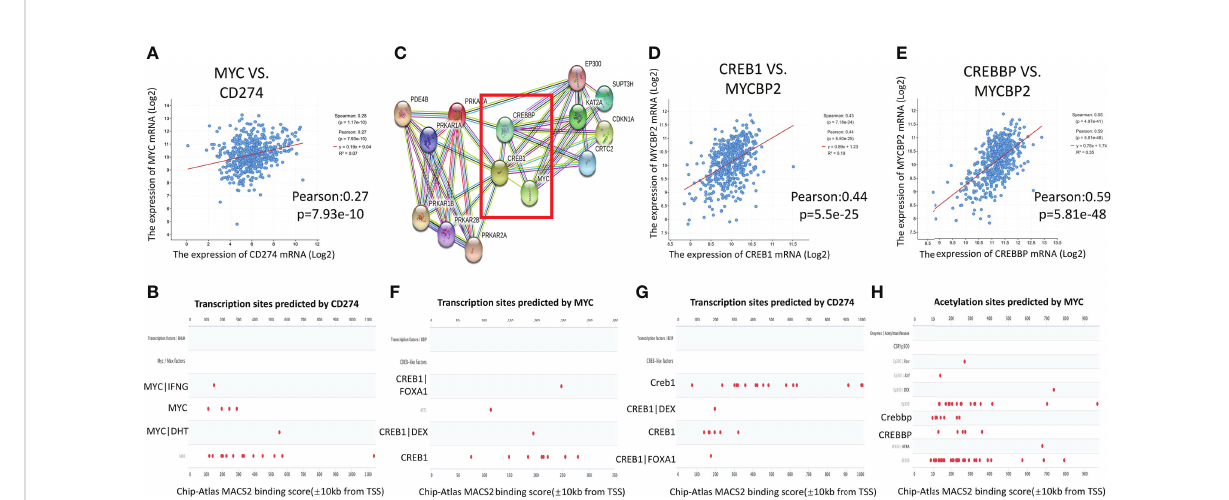
FIGURE 3 Interaction network of cAMP/CREB1/CREBP/MYC/PD-L1. (A) : MYC was positively correlated with PD-L1 gene expression in TCGA-LUAD (CBioPortal). (B) : The transcription factors of PD-L1 were queried in the Genecards database. MYC had transcriptional binding with PD-L1 in Chip-seq report. (C) : The PPI analysis between downstream molecules of the cAMP pathway and MYC was performed using the STRING website, and their co expression scores. (D, E) : CREB1 and CREBBP were positively correlated with MYC binding protein 2 expression in TCGA- LUAD (CBioPortal). (F, G) : Genecards gene database was used to predict the transcription factors of MYC and PD-L1. Chip-seq report predicted that CREB1 had transcriptional binding with MYC and PD-L1. (H) : The Chip-seq report predicted that CREBBP bound to the acetylation site of